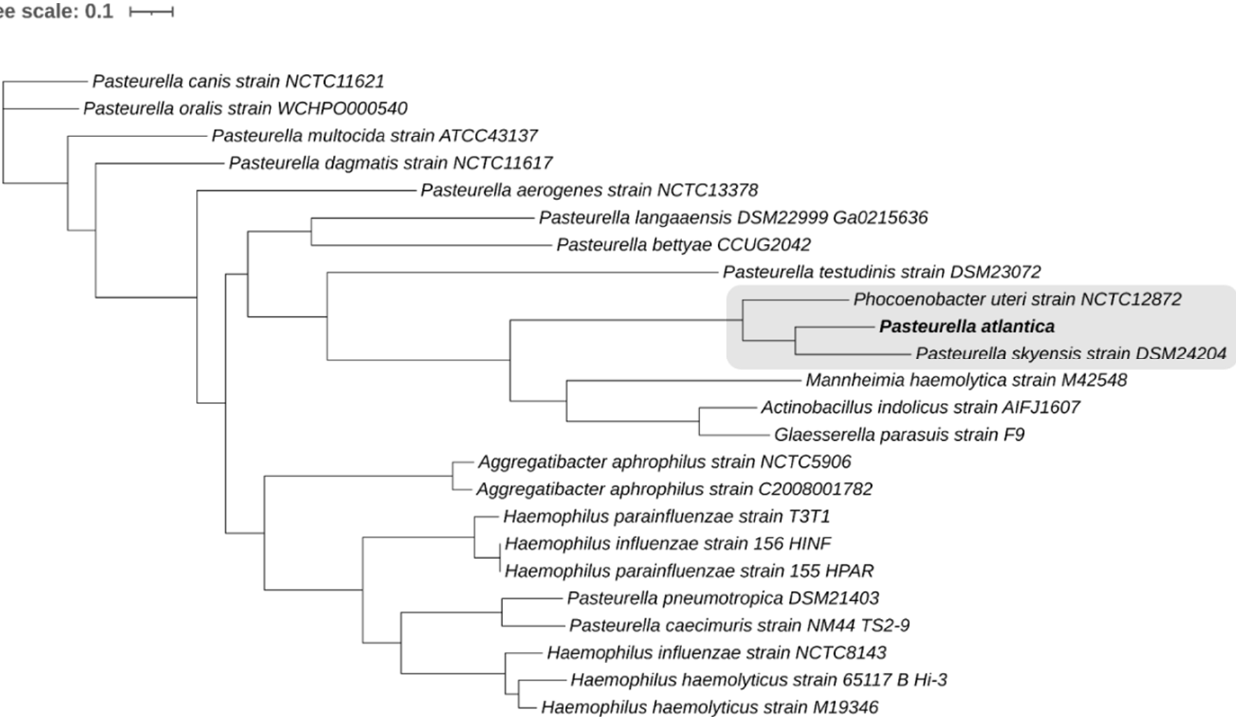
Figure 2. Phylogenetic tree of P. atlantica and Table 1 bacterial strains based on compariScheme 500 of randomly selected codons through their whole genome sequences. The monophyletic group in which the novel species belongs is highlighted, while the branch support in all nodes is >98% and has been based on 100 rounds of rapid bootstrapping.